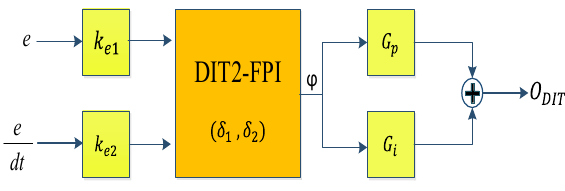
Figure 6. Diagram of DIT2-FPI controller.